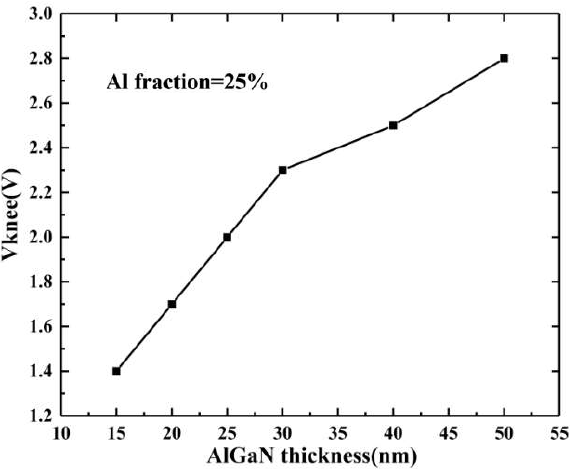
Figure 4. Variation of knee-point voltage with AlGaN thickness.